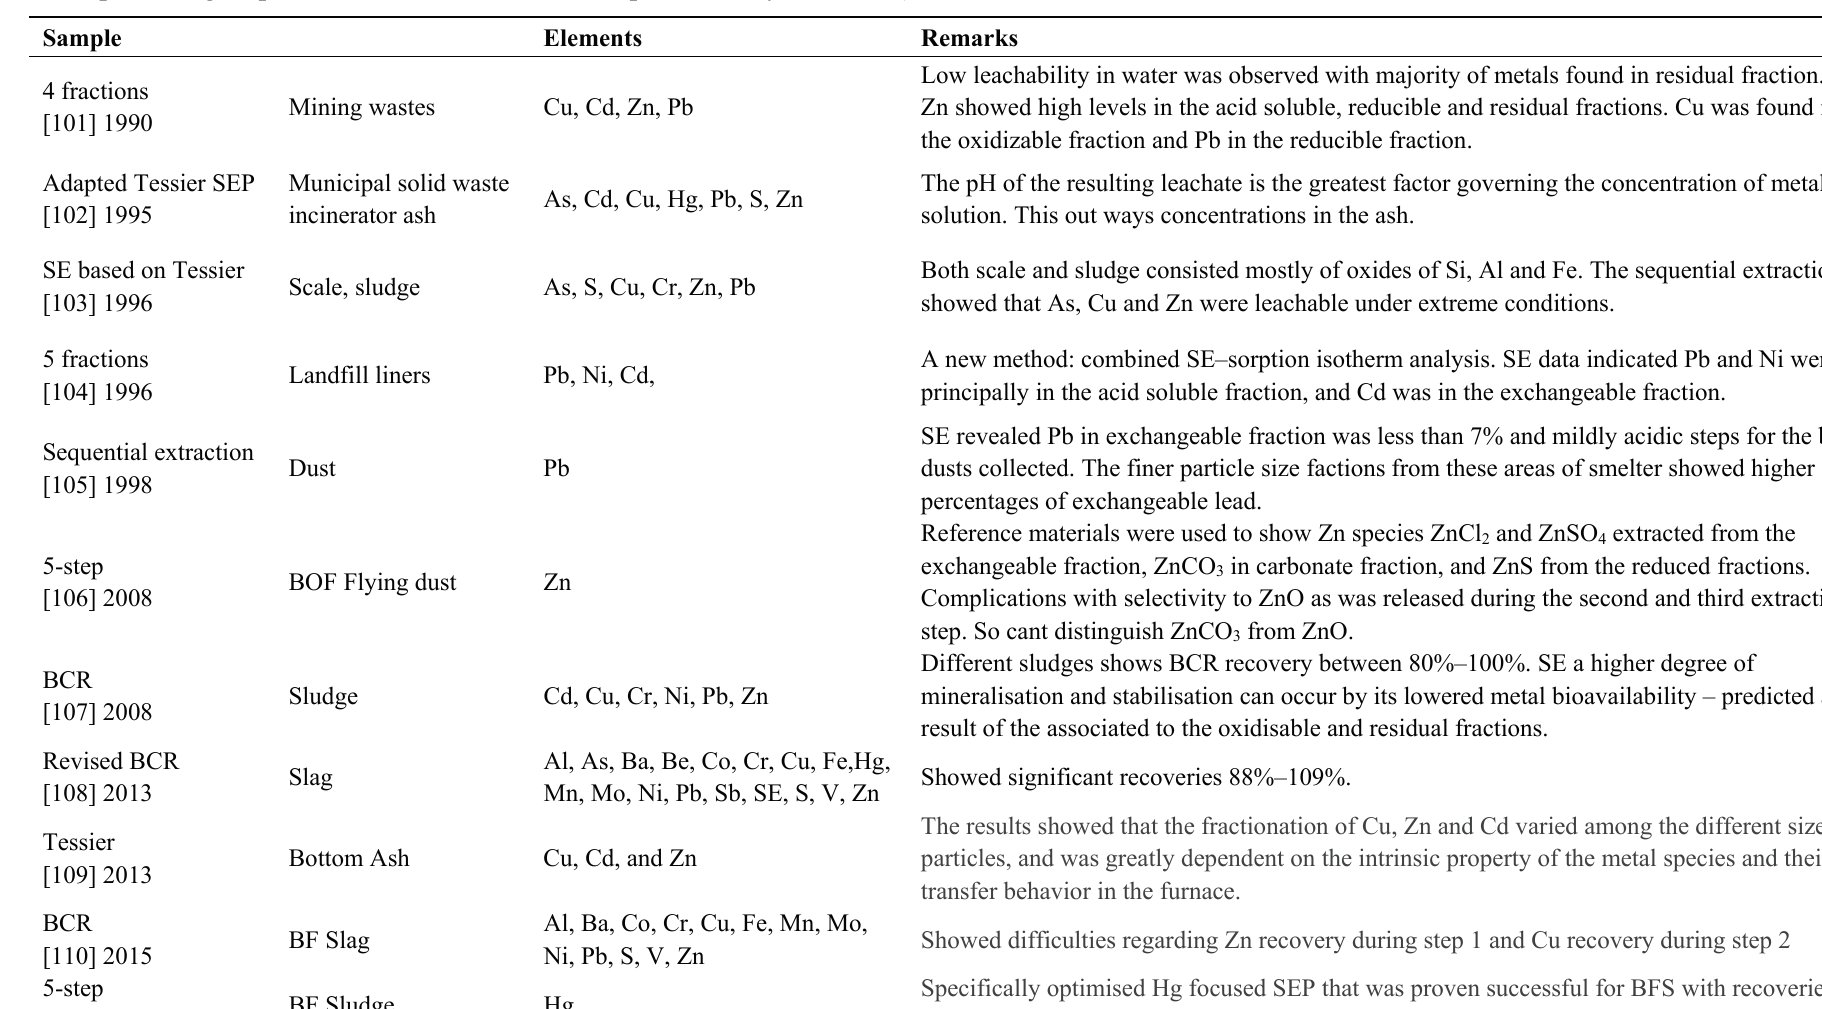
Table 6. Sequential extraction application to industrial wastes with characteristics similar to steel making wastes (key observations identified, recoveries that are not quoted were either not stated, or based on the residual fraction being the assumed difference of the pseudo total and the preceding steps, i.e. , residual fraction not experimentally